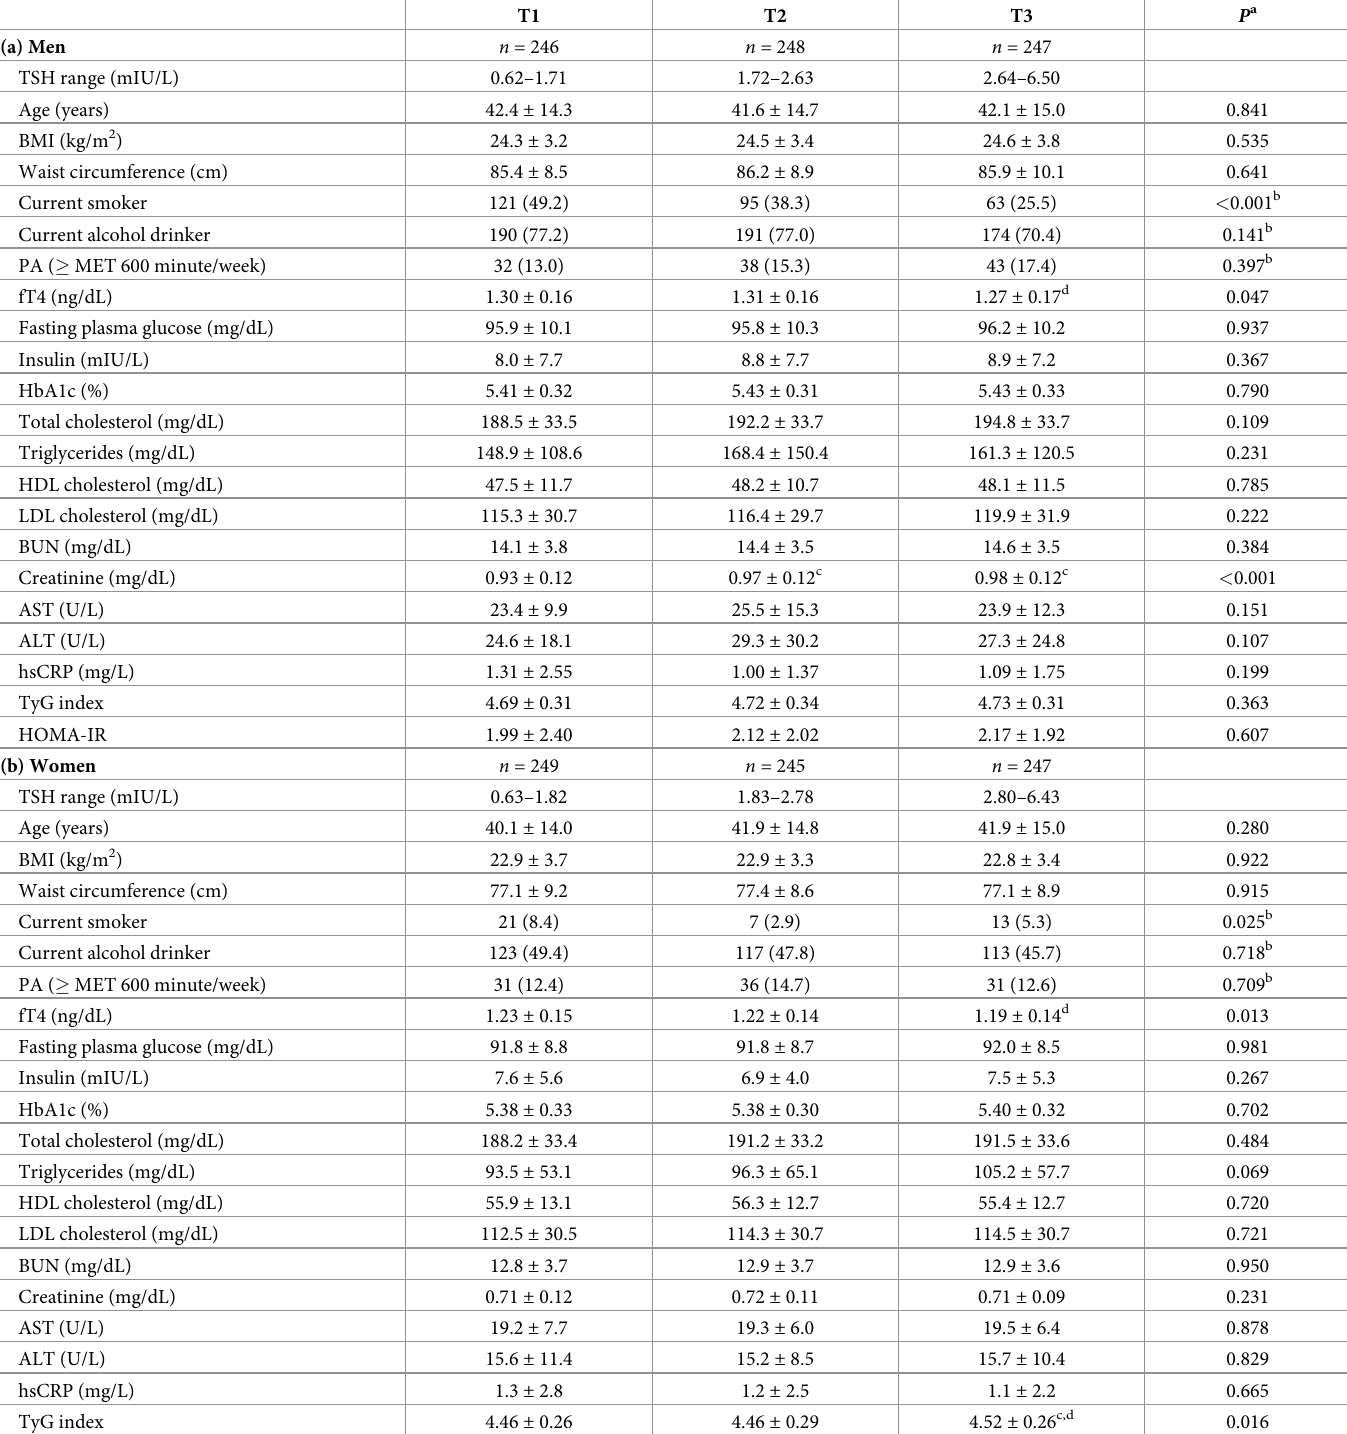
Table 3. Baseline characteristics according to TSH tertiles by